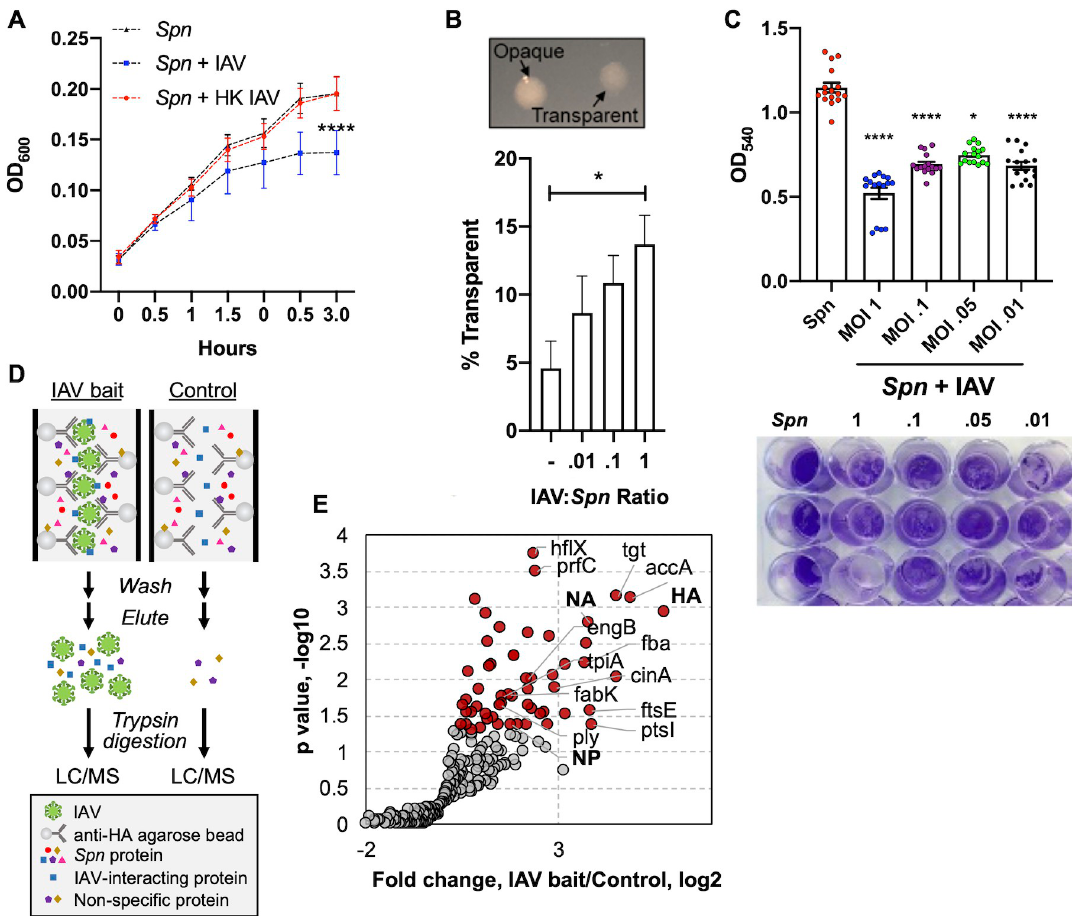
Fig 1. IAV-induced growth and morphological changes in Spn . ( A ) Growth of Spn strain TIGR4 in liquid media with/without IAV or with heat killed IAV (HK IAV). Data points represent mean ± SD. ( B ) Morphology of Spn colonies (upper panel) and counts on agar plates (lower panel) in the presence or absence of IAV. Data points represent mean ± SEM from three separate experiments. ( C ) Static biofilm of Spn on a polystyrene plate was dispersed upon 24h incubation with IAV. Spn was stained by crystal violet. Quantitation was done by measure of absorbance at 540nm. ( D ) Schematic illustration of the experimental process for Affinity Enrichment Mass Spectrometry (AE-MS) Liquid chromatography–mass spectrometry (LC/MS). Influenza virus particles were bound to hemagglutinin (HA) antibody immobilized on agarose beads, which serve as bait to enrich Spn proteins. The control experiment did not contain the IAV bait. ( E ) Volcano plot showing proteins identified in the AE-MS analysis. Proteins significantly enriched in the presence of IAV bait (Student’s t-test, p < 0.05) are shown in red. IAV proteins HA, neuraminidase (NA) and nucleoprotein (NP), in addition to Spn cytolysin pneumolysin (ply), are shown bolded. Kruskal-Wallis test with Dunn’s multiple-comparison post-test. Asterisks denote the level of significance observed: � = p � 0.05; �� = p � 0.01; ��� = p � 0.001. particles to the antibody coated beads. Each experiment was performed in triplicate and pro- tein quantitation was performed using the label-free quantitation (LFQ) approach. Both the control and experimental group comprise of 200–300 quantifiable proteins, sug- gesting high background from non-specific interactions of Spn proteins to anti-HA beads. IAV proteins Hemagglutinin (HA), Neuraminidase (NA), and Nucleoprotein (NP) were confi- dently identified in the experimental group but not in the control group, indicating successful coating of anti-HA beads with IAV particles. After statistical analysis (Student’s t-test, p < 0.05), 53 Spn proteins were found to be significantly enriched in the experimental group (i.e., with IAV particles) ( Fig 1E and S1 Data ), 42 of which were increased by more than 2-fold. Of interest, one of the enriched proteins was pneumolysin (Ply) (increased by nearly